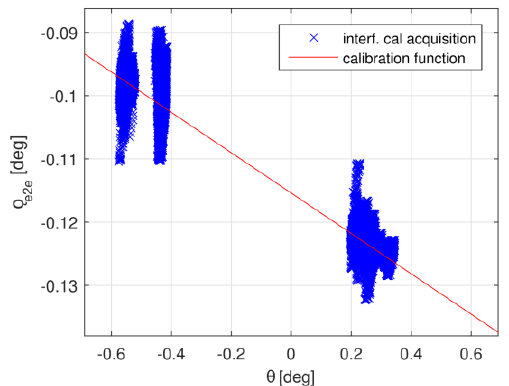
Figure 3. End-to-end error in the angle of arrival for calibration campaign #3 as a function of the angle of arrival and the corresponding calibration function. The blue points represent the individual interferometric measurements and the red line the linear regression over them. Figure taken from [9].